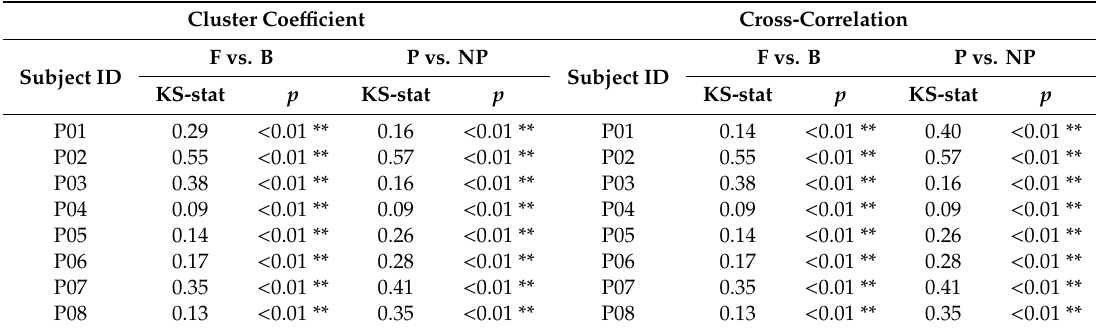
Table A1. Kolmogorov–Smirnov test statistics (KS-stat) and their p -values (p) on cluster coe ffi cients comparison (left) and cross-correlation (right) between di ff erent movement segments (forward (F) vs. backward (B)) and di ff erent sides (performing (P) vs. non-performing (NP)) 1